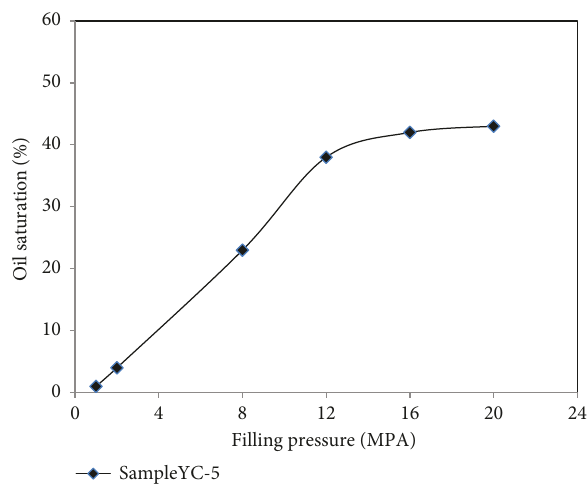
Figure 5: The relationship between filling pressure and oil satu- ration is a rapid growth-slow growth